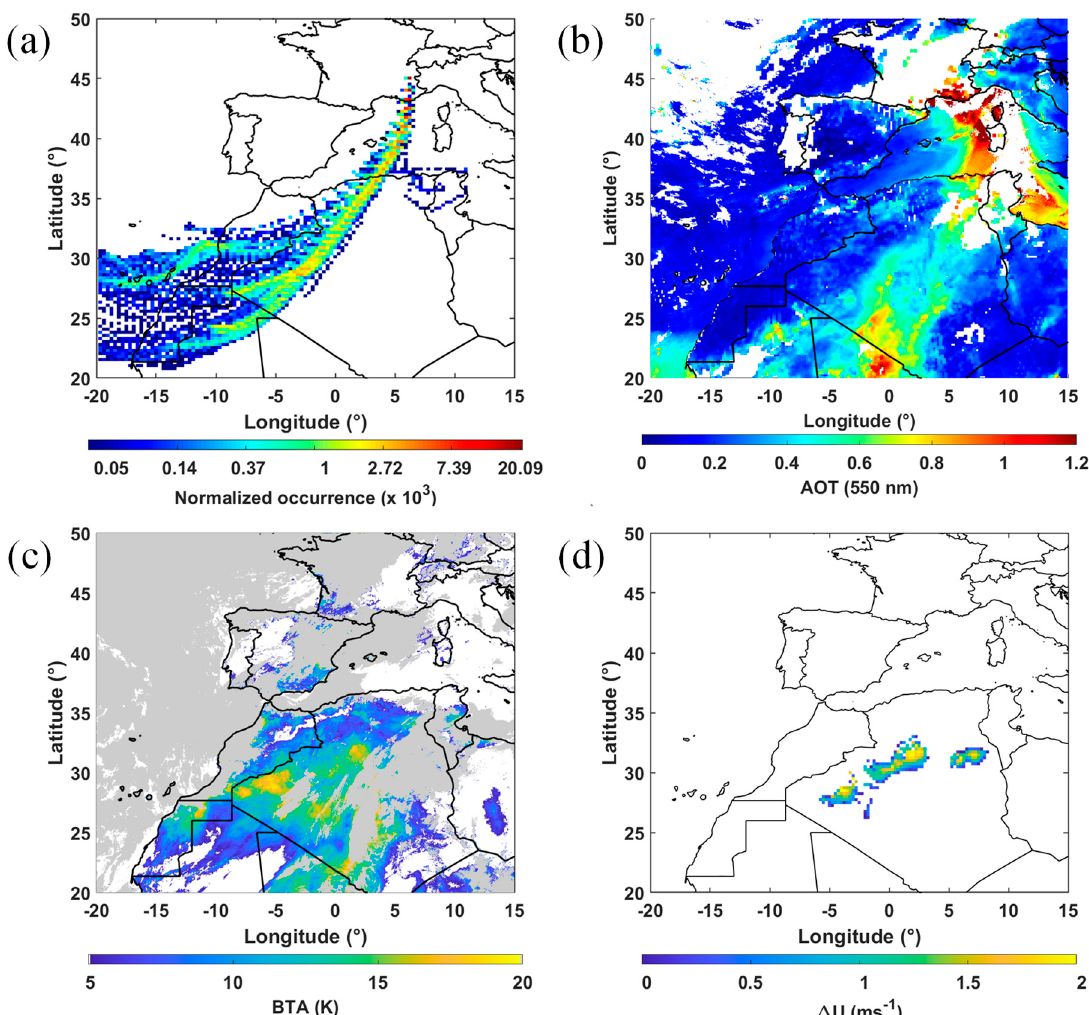
Figure 10. ( a ) Normalized occurrence of the contribution to the air masses going over the ground- based lidar on 14 June 2019, at 16:00 UTC. The calculations have been performed using three–day back trajectories in ensemble mode between 4 and 6 km a.m.s.l., in steps of 0.1 km. ( b ) aerosol optical thickness (AOT) at 550 nm derived from MODIS on 14 June 2019. ( c ) Brightness temperature anomaly (BTA) on 13 June 2019, at 12:00 UTC. The cloud mask has been applied, here colored in gray. ( d ) Weighted difference between the horizontal velocity ( U 10 ) and the friction velocity ( 𝑈 (cid:2869)(cid:2868)∗ ) at 10 m a.g.l. ( ∆𝑈 (cid:3404) 1.1 𝑈 (cid:2869)(cid:2868)∗ (cid:3398) 𝑈 (cid:2869)(cid:2868) ).